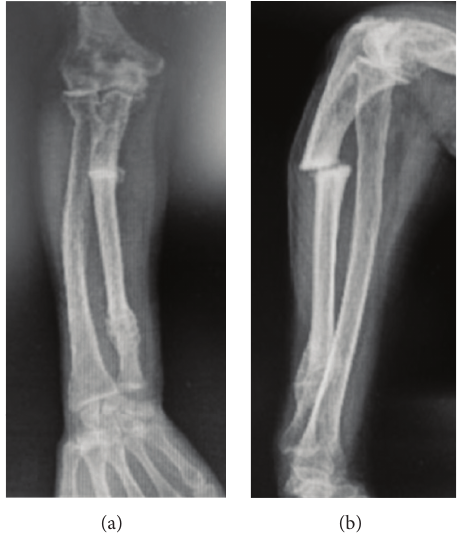
Figure 3: Forearm radiographs at the 6th week follow-up demonstrating the